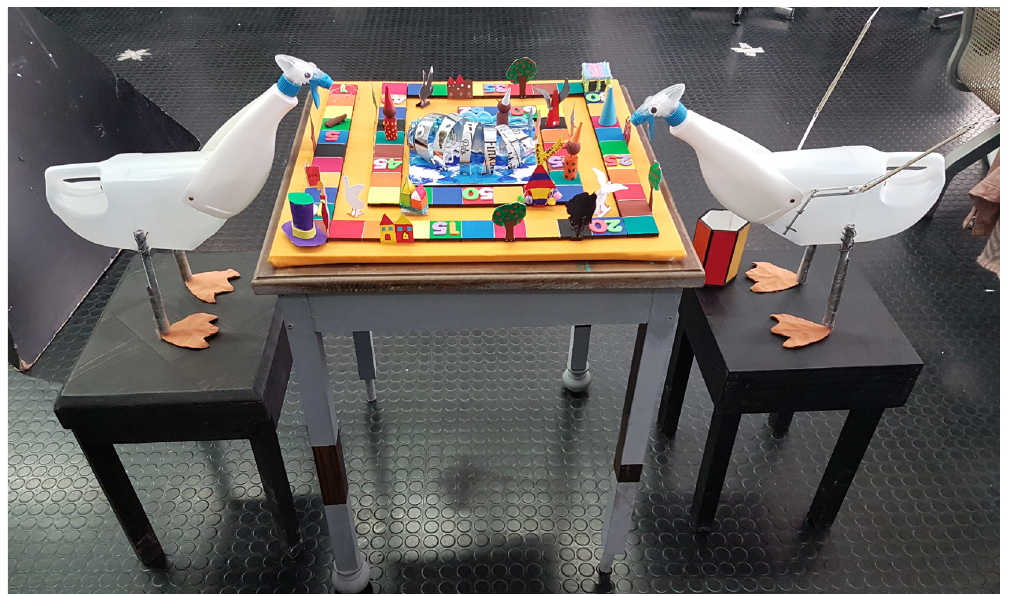
Fig. 3 Labyrinth and Gioco dell’oca work